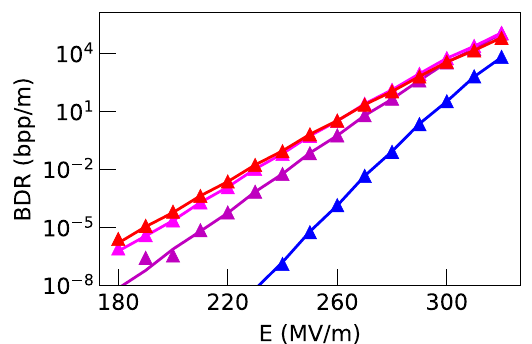
FIG. 12. BDR as a function of the electric field calculated using the exact formula [Eq. (9), lines] and the simulation (triangles). The results are plotted, from bottom to top, for temperatures of 100, 200, 300, and 400 K.